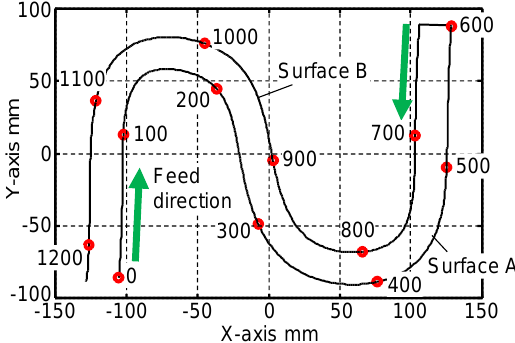
Figure 5. Motion trajectory of the tool center-point and its displacement from starting point.